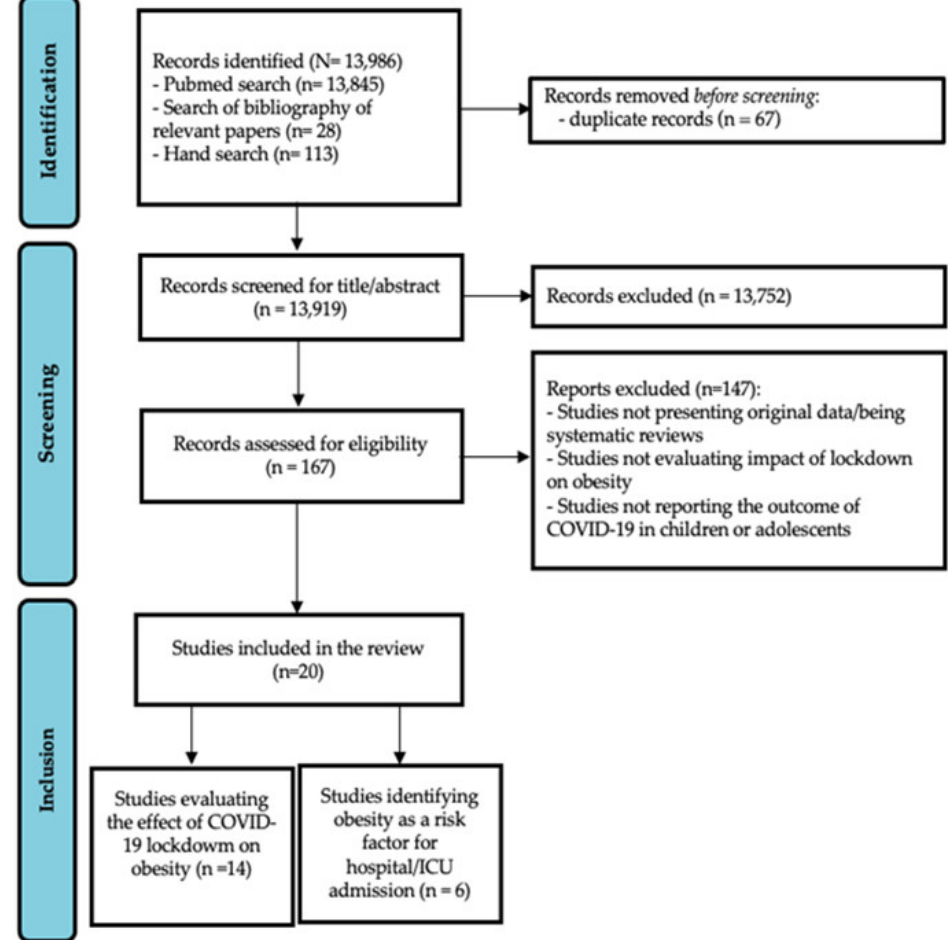
Figure 1. PRISMA flow chart showing the study selection process.